Question: Condense the content of this figure into a single sentence.
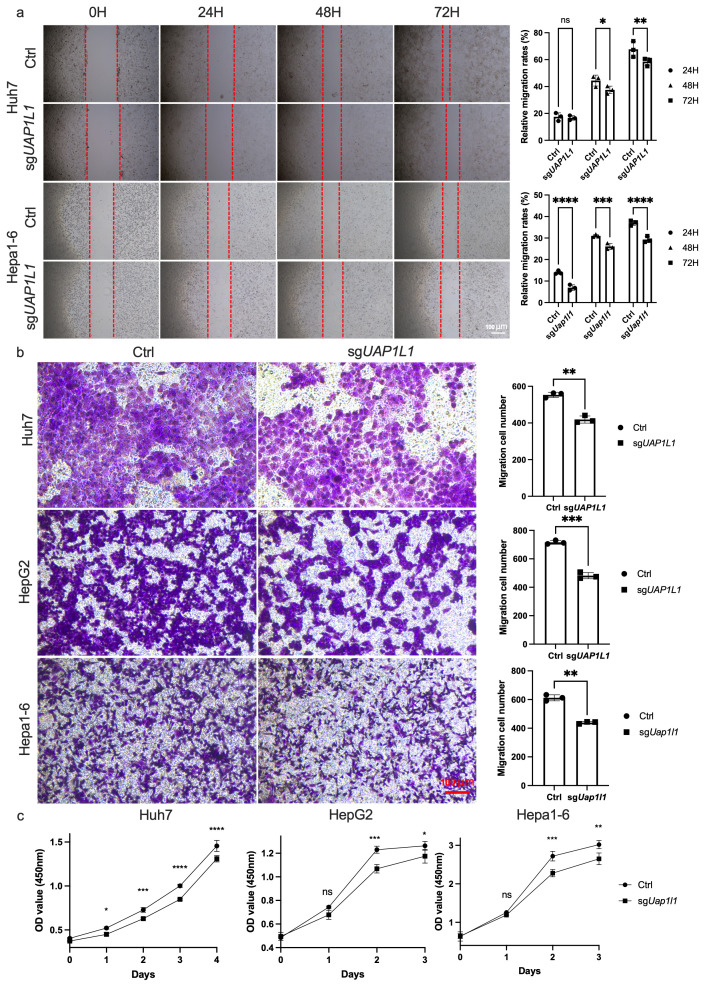
Answer: UAP1L1 promotes HCC cells proliferation and invasion. (A) Wound healing assays revealed a decrease in the migration ability of Huh7 and Hepa1–6 cells in the sg UAP1L1 group compared to the Ctrl group. Quantification of Wound healing assays results showing a decrease in wound closure percentage in the sg UAP1L1 group compared to the Ctrl group. Scale bar: 100 μm. (B) Transwell assay demonstrated a decrease in the migration ability of Huh7, HepG2 and Hepa1–6 cells in the sg UAP1L1 group compared to the Ctrl group. Quantification of Transwell assay results showing a decrease in the number of invading cells in the sg UAP1L1 group compared to the Ctrl group. Scale bar: 100 μm. (C) CCK-8 assay further confirmed the inhibitory effect of UAP1L1 silencing on Huh7, HepG2 and Hepa1–6 cells proliferation. *, P<0.05; **, P<0.01; ***, P<0.001; ****, P<0.0001.